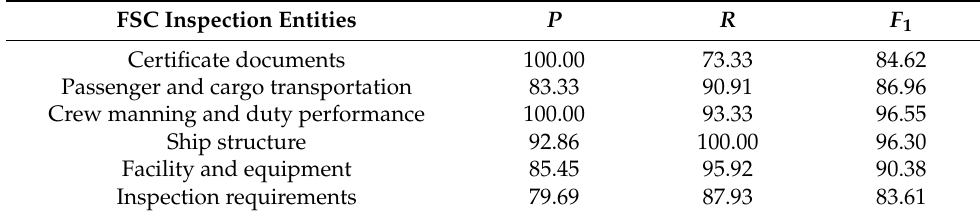
Table 5. Results of various types of FSC inspection entities